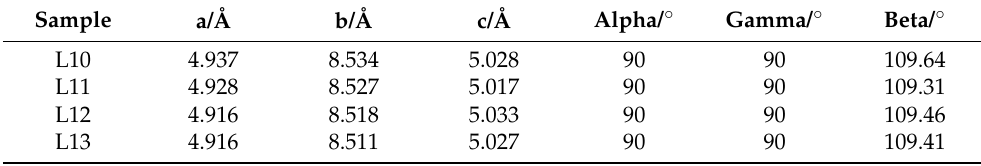
Table 2. Lattice parameters of samples L10–L13 for existence of the monoclinic Li 2 MnO 3 phase.